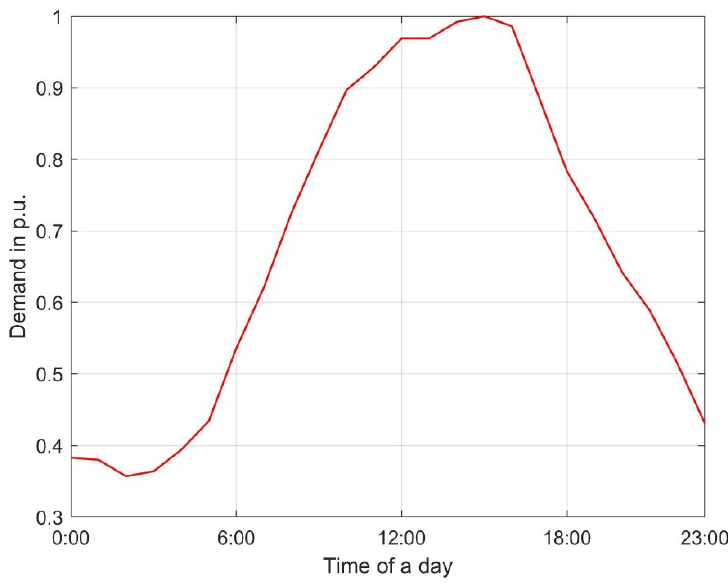
Figure 5. Typical demand data.